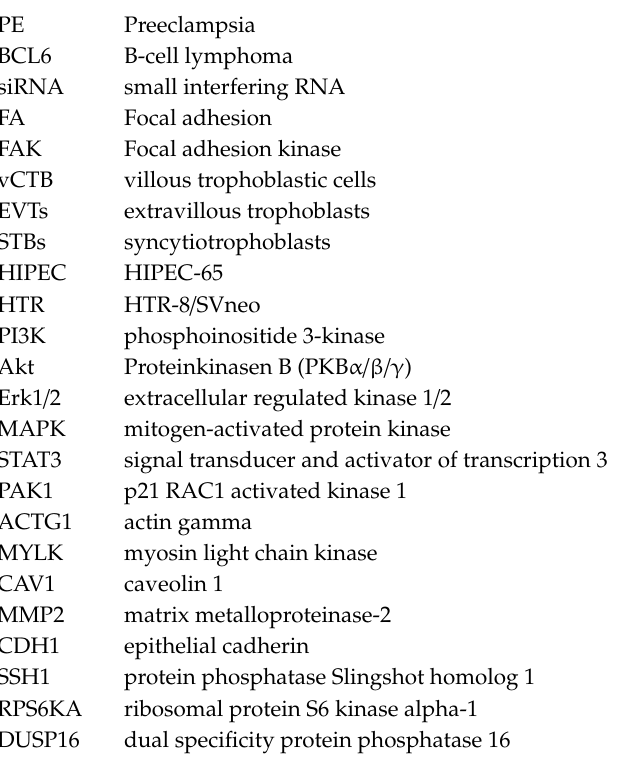
Figure S1. Inhibition of BCL6 reduces the migration of trophoblastic cells; Figure S2. Suppression of BCL6 reduces the motility of first trimester trophoblastic cells; Figure S3. Cell adhesion and integrin activation are compromised in HIPEC cells with reduced BCL6; Figure S4. Reduced paxillin, p-paxillin, FAK, and p-FAK at FAs of HIPEC cells deficient of BCL6; Figure S5. Reduced paxillin, p-paxillin, FAK, and p-FAK at FAs of SGHPL-4 cells deficient of BCL6; Figure S6. Reduction of BCL6 reduces the levels of ACTG1, PAK1, and CAV1 related to